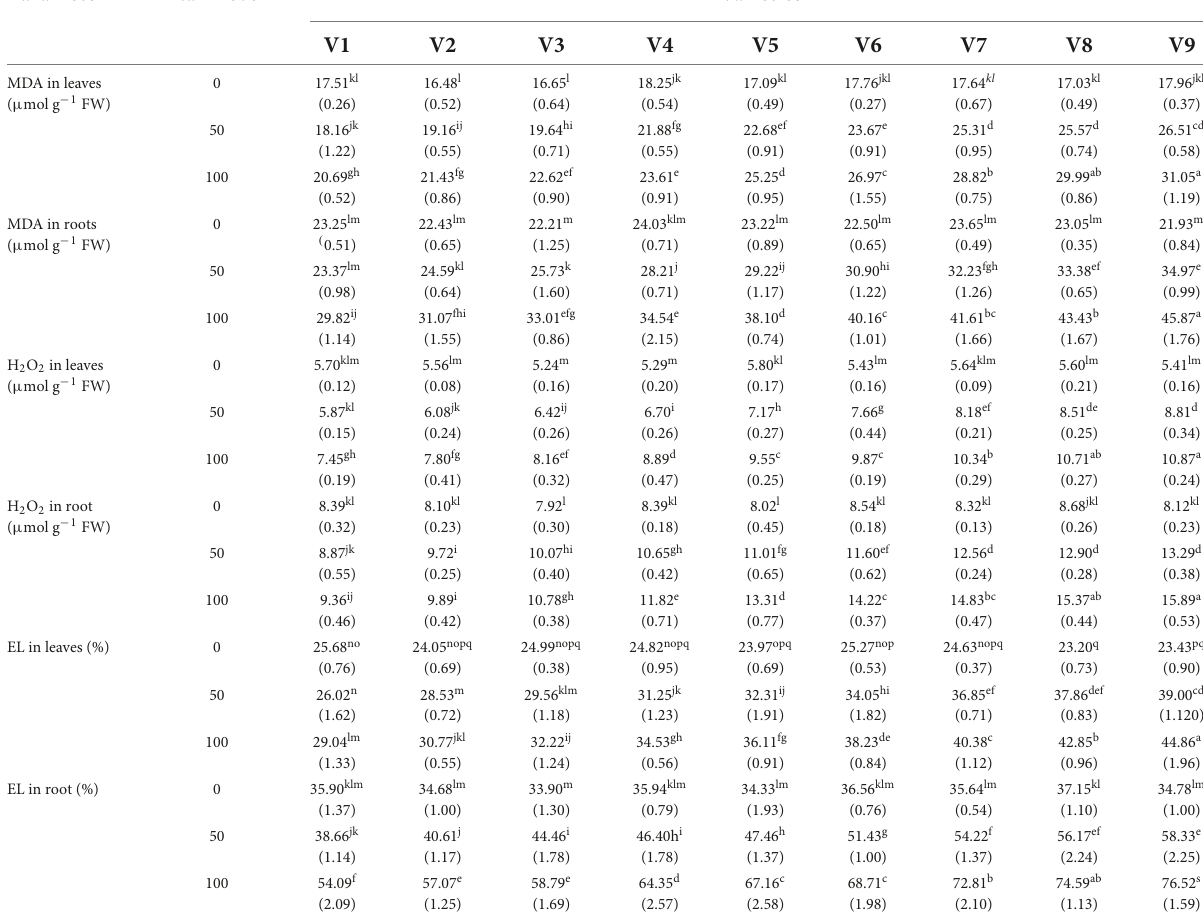
Valuesareexpressedasmeansofthreereplicateswithstandarddeviations. Differentlettersindicatethatvaluesaresignificantlydifferentat p < 0.05. TABLE 2 Effect of different concentrations of NaCl on oxidative stress of different barley genotypes. Parameter Na + Level